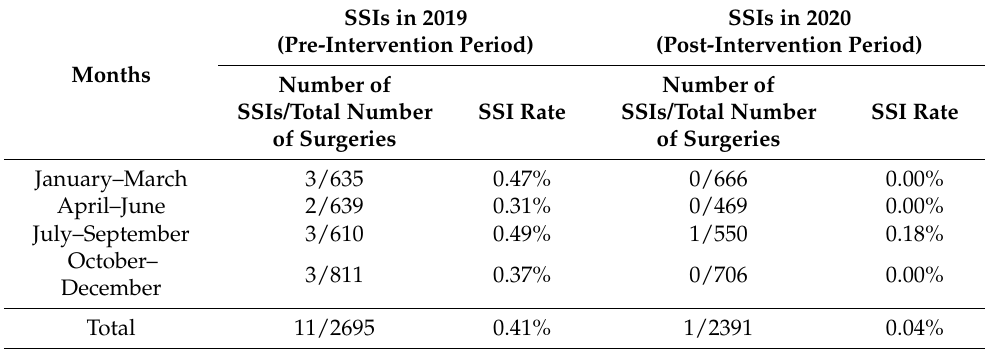
Table 5. Number of SSIs recorded in 2019 and 2020.